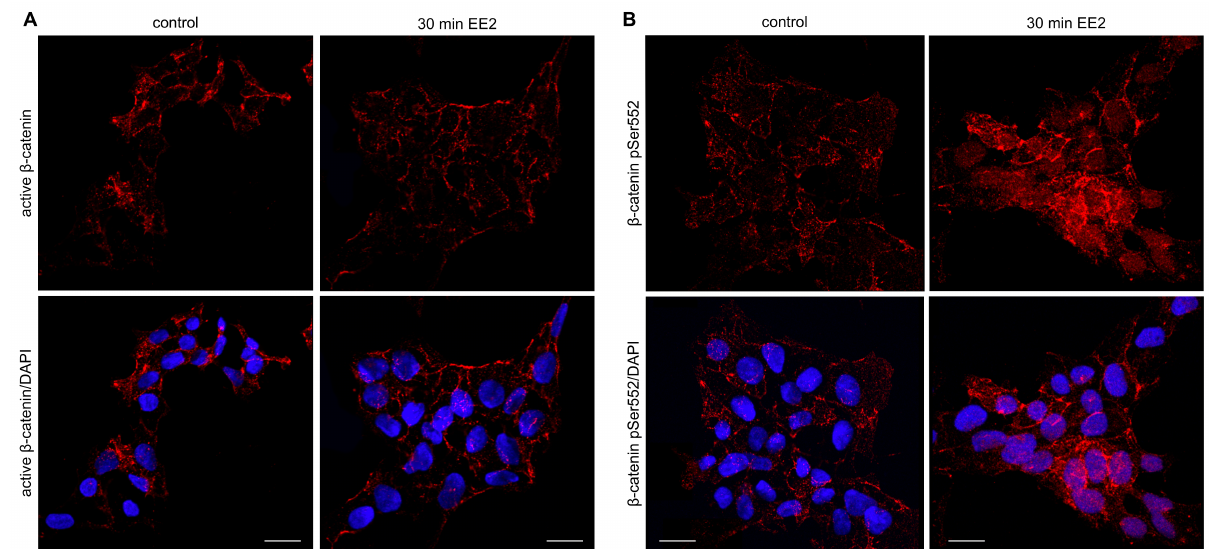
Figure 7. Immunofluorescence staining of active (non-phosphorylated Ser33, Ser37, Thr41) and phosphorylated (pSer552) β -catenin in NT2/D1 cells after 30 min of culture. ( A ) Active β -catenin (red) was present at the cell membrane of both control and 30-min EE2 treated NT2/D1 cells, indicating oestrogen had no effect on its localisation. ( B ) β -catenin pSer552 (red) was present primarily at the cell membrane of control NT2/D1 cells, with a small amount throughout the cytoplasm. NT2/D1 cells treated with 100 nM EE2 for 30 min showed a marked increase in the nuclear (DAPI; blue) localisation of β -catenin pSer552, as well as an increase in the overall signal, demonstrating activation of β -catenin through phosphorylation at this site. Scale bar = 20 µ